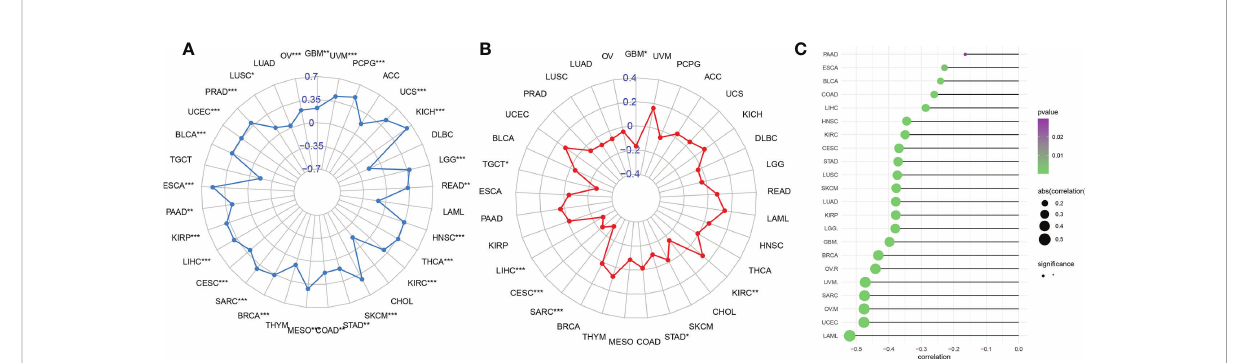
FIGURE 12 Relationship between AIM2 in fl ammasomes scores and markers of immunotherapeutic response in human cancers. (A) Correlation of AIM2 in fl ammasomes scores with tumor mutation burden in cancer (Spearman ’ s correlation test). (B) Correlation of AIM2 in fl ammasomes scores with microsatellite instability in cancer (Spearman ’ s correlation test). (C) Correlation of AIM2 in fl ammasomes scores with tumor immune dysfunction and exclusion scores. *p < 0.05, **p < 0.01, and ***p < 0.001 (Spearman ’ s correlation